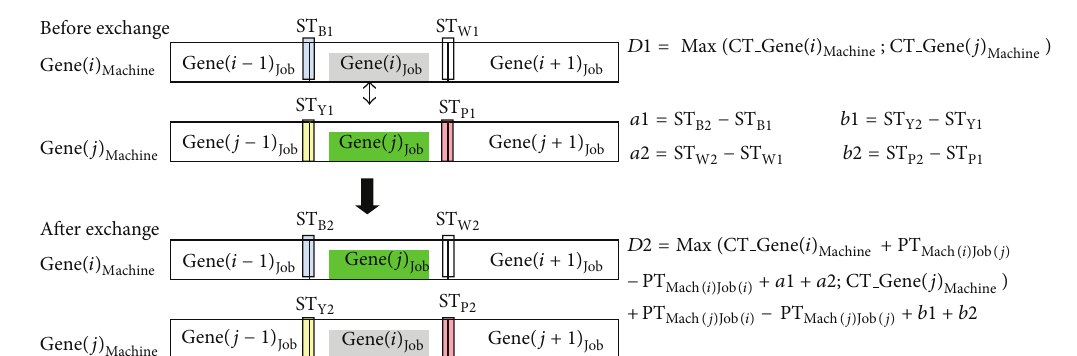
and Gene (𝑗) on the schedule). Job Job